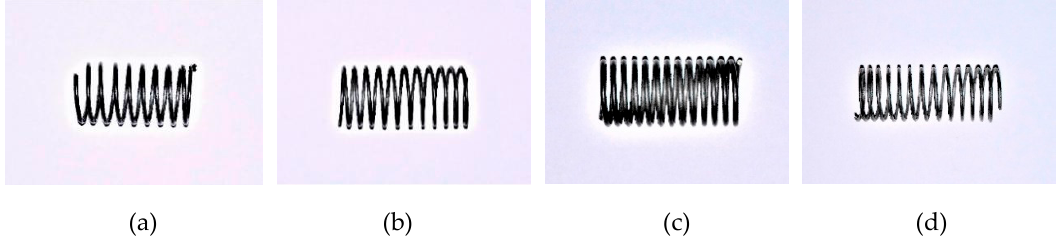
Figure 6. Heating and tension test equipment: ( a ) the oven; ( b ) the tensile test machine.